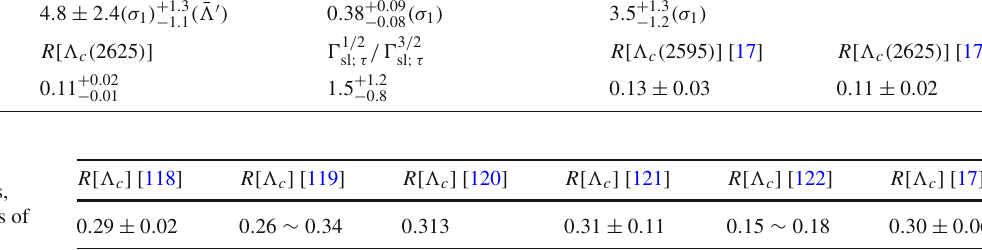
final baryon states, and (cid:6) sl [ (cid:2) b → (cid:2) c ( 2595 ) ] /(cid:6) sl [ (cid:2) b → (cid:2) c ( 2625 ) ] forthe τ ¯ ν τ semileptonicmode.Errorsarederivedfromtheuncertainties on the σ 1 form-factor and the ¯ (cid:2) (cid:9) parameter, and are added in quadra- ture for the ratios shown in the last three columns. Central values are obtained for σ 1 (ω) = 0 in all cases. Results from Ref. [17] are taken